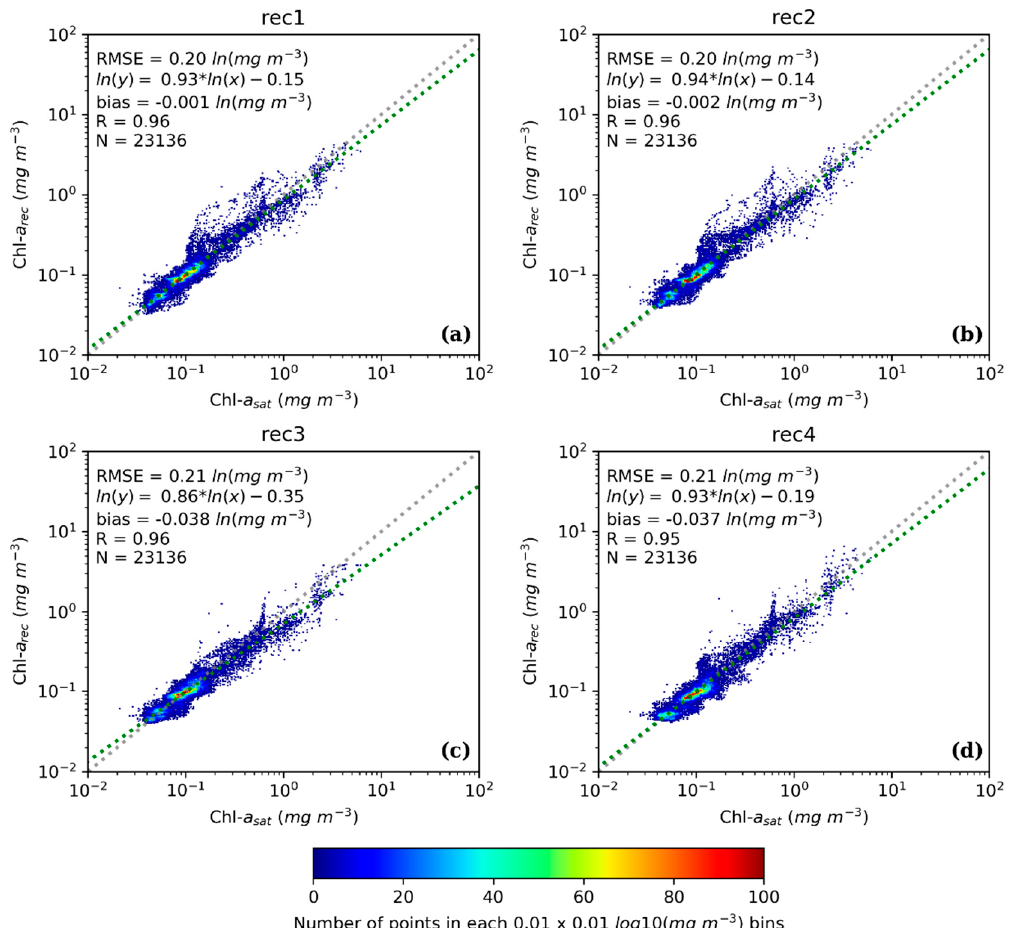
Figure 12. Scatterplots of the CV-data (Chl- a sat ) versus the corresponding modeled data (Chl- a rec ) for the four reconstruction schemes on 17 May, 2018. Color scale indicates the number of points in each 0.01 * 0.01 log10 (mg m − 3 ) bin. Green dotted lines show the best fit line and grey dotted lines represent the 1:1 line.